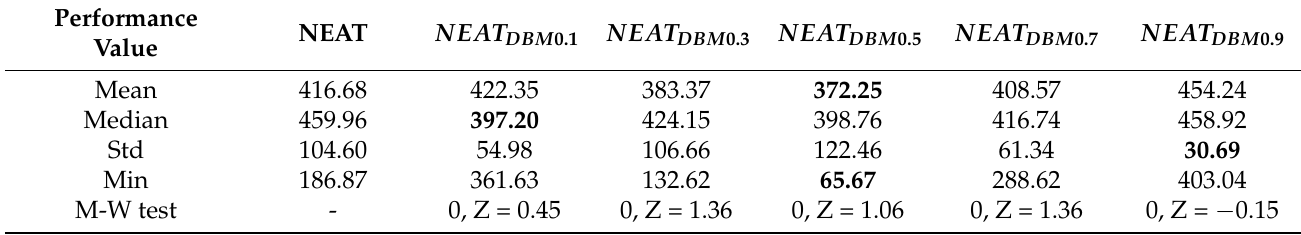
Table 11. NEAT vs NEAT DBM performance for RIP